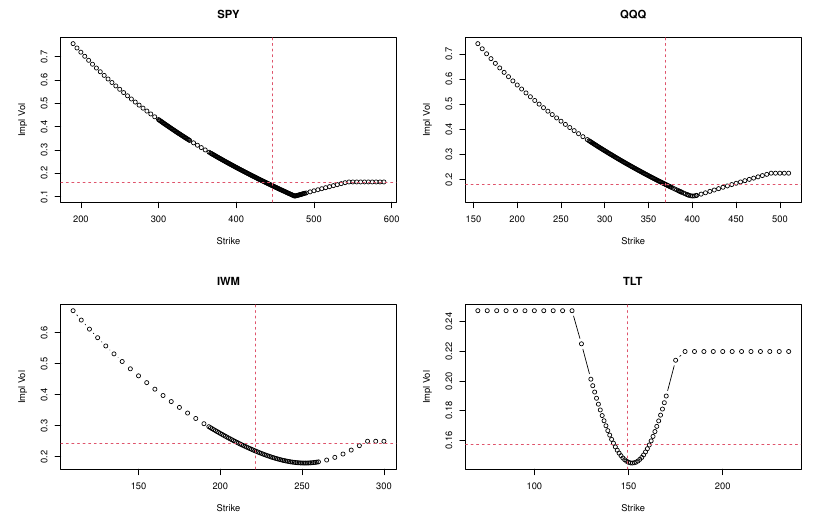
Figure 1. The volatility ‘smiles’ of the the 15 October 2021 option series (calls) as observed and calculated on 13 August 2021 (EOD) for the three market index ETFs, SPY, IWM and QQQ and on 18 August 2021 (EOD) for the TLT